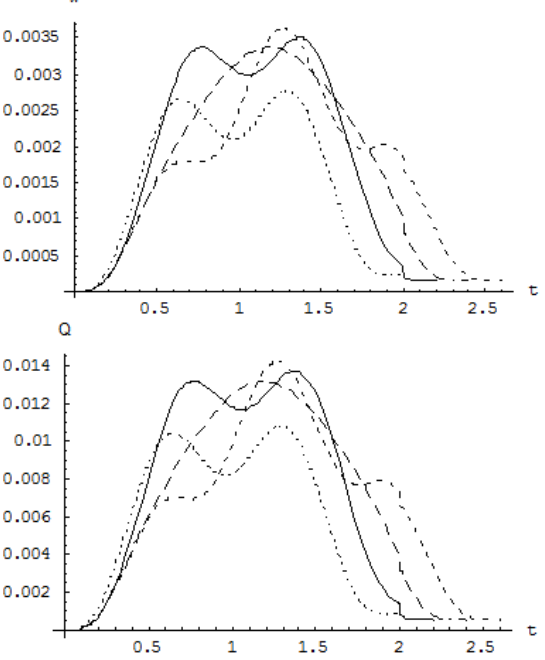
Figure 27: The influence of the vehicle length for R = 50 m, υ = 30 m/s, e H = 3.00 m, e V = 1.20 m and d = 3 m ( __ ), d = 5 m ( _ _ ), d = 7 m (- - - ) and d = 0 m ( ....